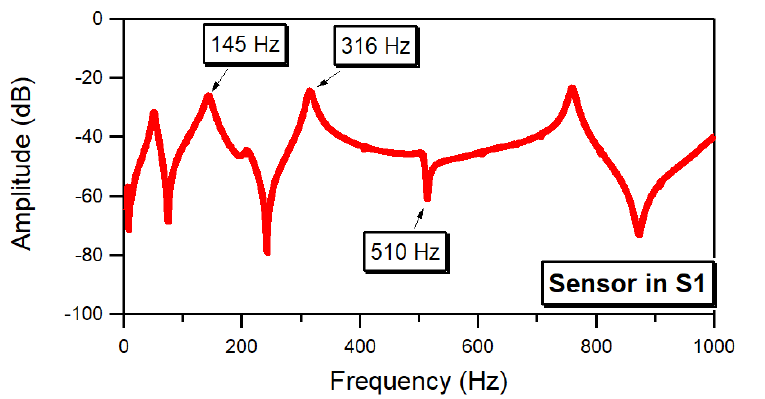
Figure 5. Spectral response of the beam in the low frequency range acquired at position S1.